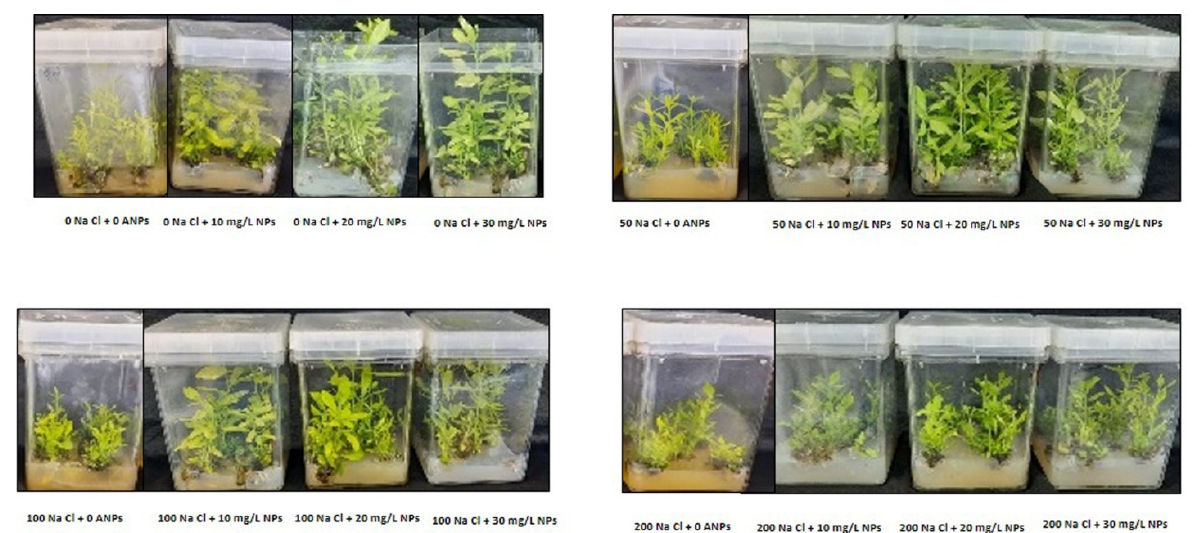
Figure 3. Shoots of Maerua oblongifolia plants under NaCl stress and application of biosynthesized silver nanoparticles. Table 1. Effect of silver nanoparticles on the in vitro regeneration of Maerua oblongifolia exposed to salt stress after 45 days of treatment in MS media.